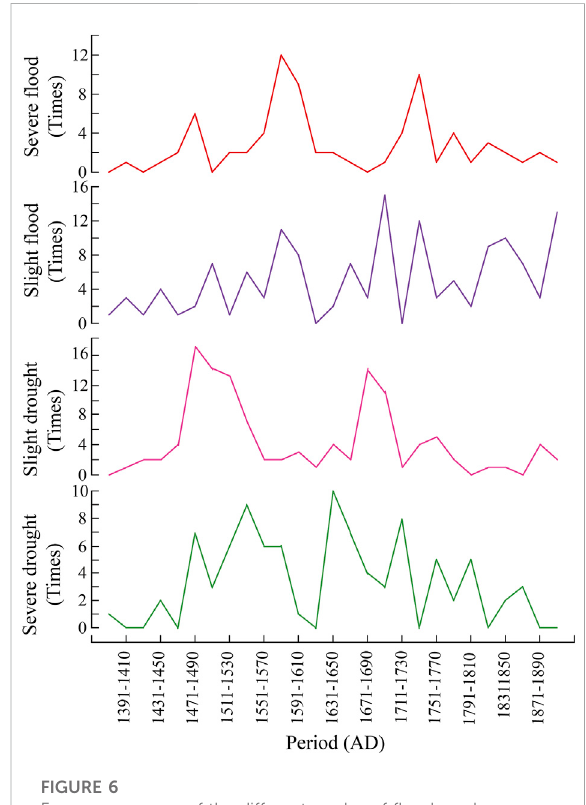
FIGURE 6 Frequency curves of the different grades of fl oods and droughts in the Huizhou